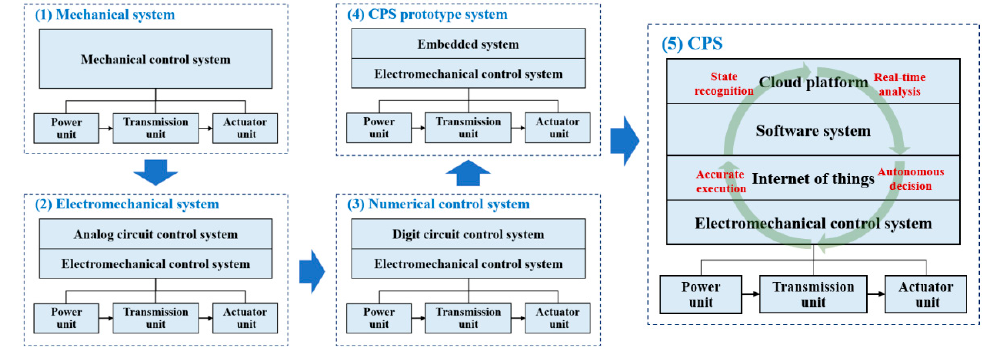
Figure 11. The evolution of control system to CPS.